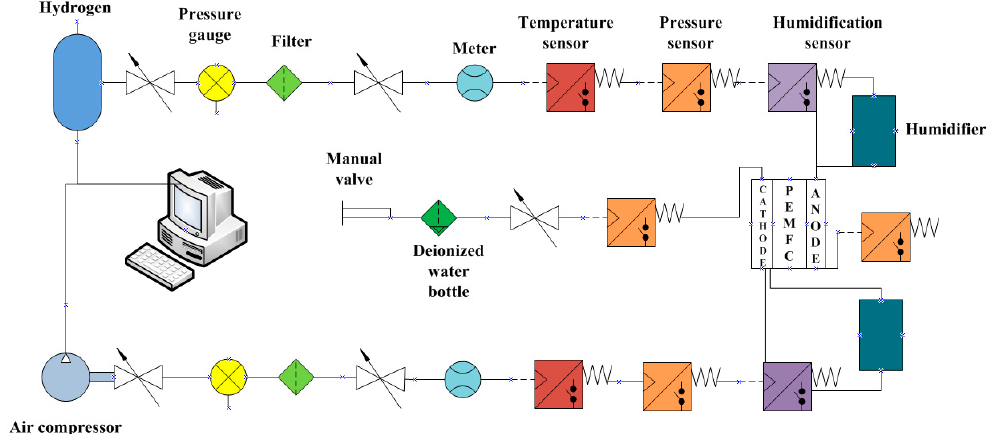
Figure 4. Test schematic. Relative humidity and other parameters are controlled and recorded by a personal computer (PC) and instances of pressure drop are taken manually.